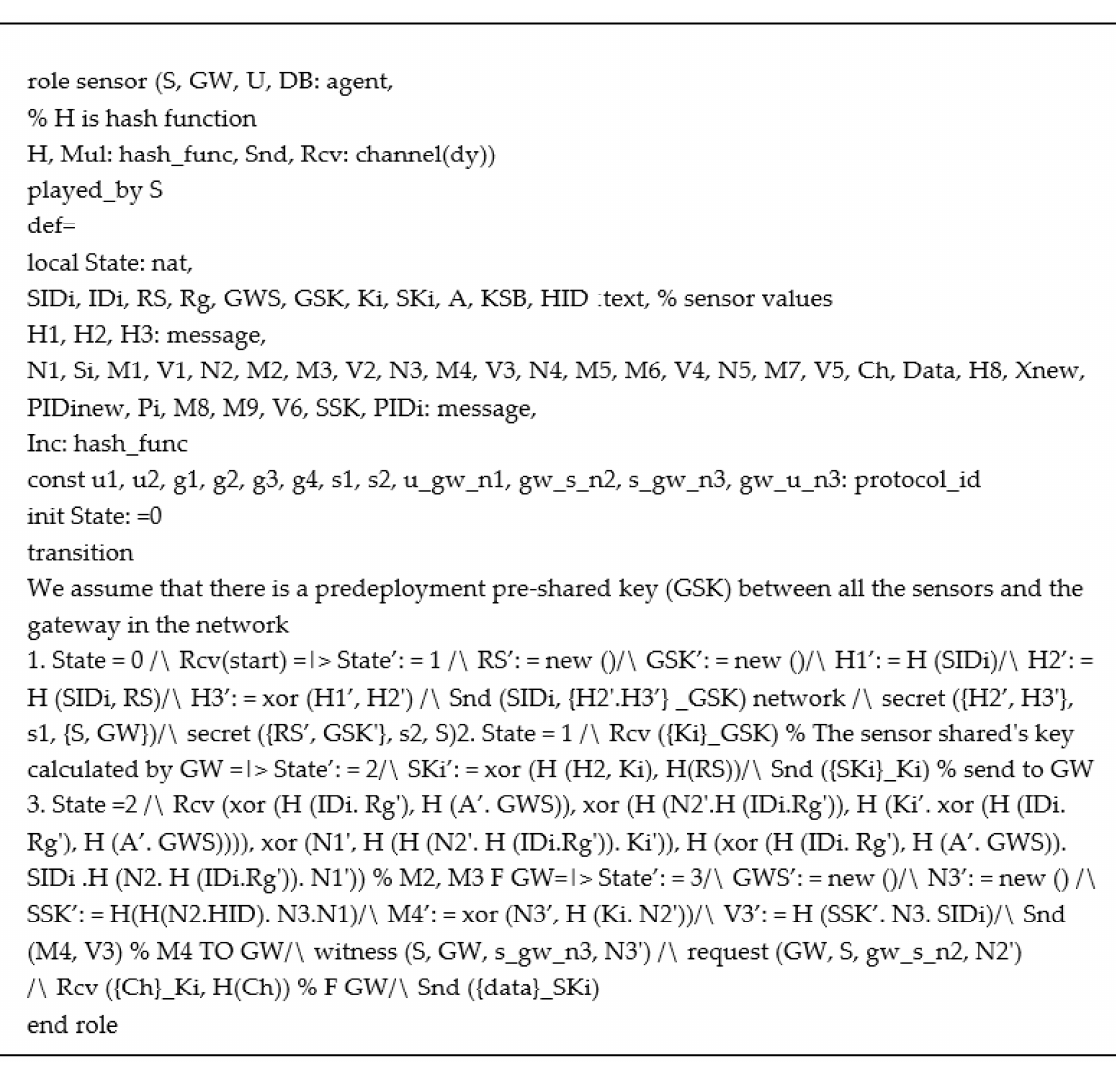
Figure A3. Role of the sensor.